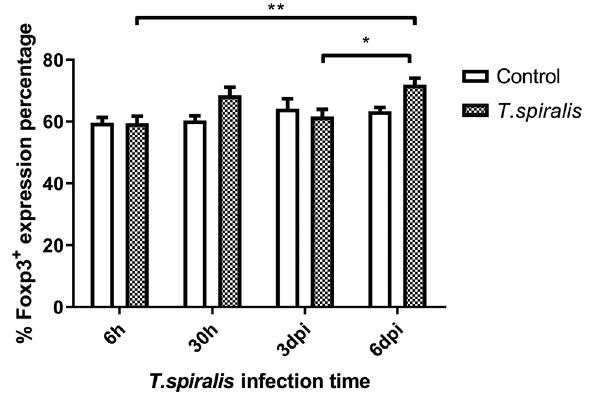
Figure 6. Percentage and expression levels of Foxp3 + of Treg cells in mice infected with 250 muscle larvae of Trichinella spiralis compared to uninfected (control) mice from 6 h to 6 dpi. * p < 0.05 and ** p < 0.01 indicating a statistically signi fi cant difference.